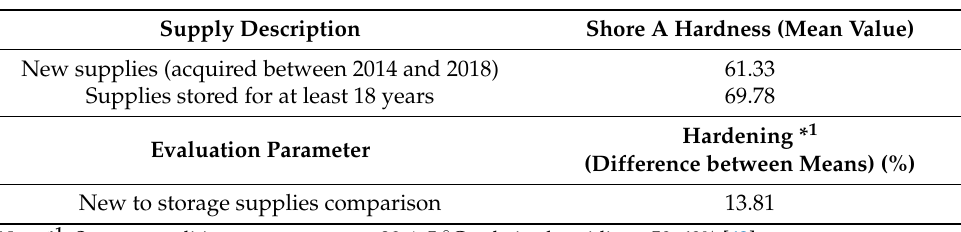
Table 4. Experimental data analyzed in this work 1 .